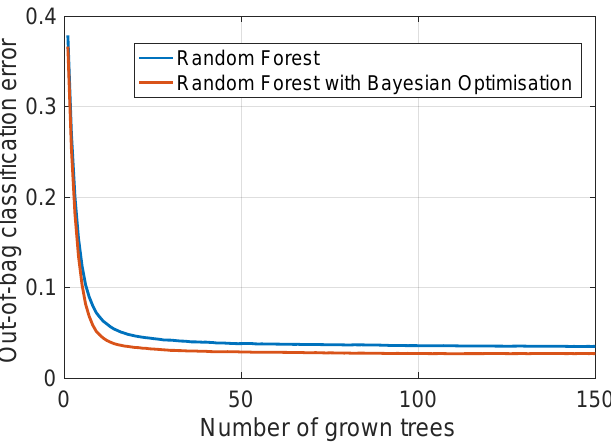
Figure 8. The out-of-bag error over the number of grown trees using different methods.